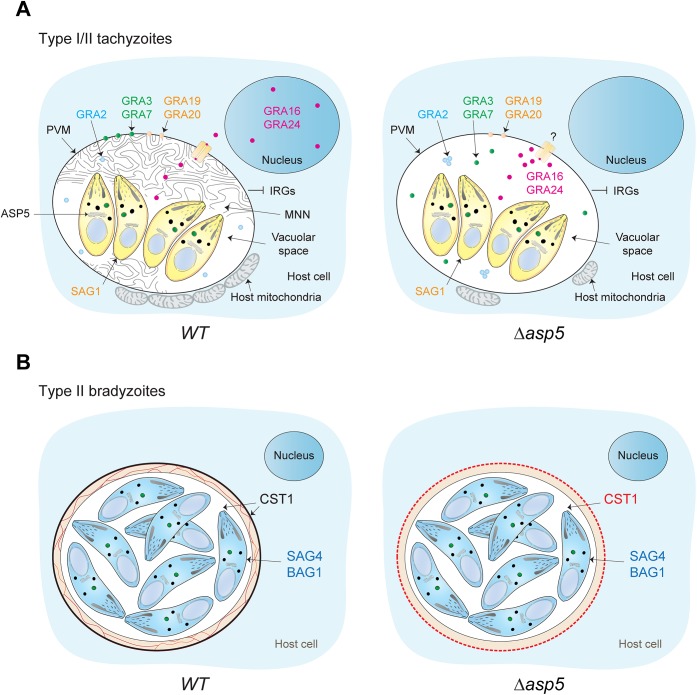
Stage specific functions of ASP5 in T. gondii.(A) Schematic representation of a host cell infected by either type I or type II tachyzoites. In a wt situation (left panel), intracellular tachyzoites reside within an MNN containing PV. During intracellular development, dense granule proteins are delivered either to the vacuolar space, the PVM, or are addressed to the host cell cytosol and nucleus. Intriguingly, the absence of ASP5 (right panel) does not affect the secretion of the dense granules, and accordingly, PEXEL-like and non-PEXEL-like motif-containing proteins are still delivered to the PV. However, ASP5 deletion leads to the disappearance of the MNN, altered localization of some PV- and PVM-resident GRAs, and to the PV-accumulation of proteins normally exported to the host cell cytosol. Accordingly, the overall infected host cell transcription profile response is significantly different in Δasp5 parasites infection. The accumulation of some exported GRAs in the PV suggests that the export machinery used to cross the PVM is affected upon ASP5 deletion. In contrast, no significant effect was observed for early host organelle recruitment to the PVM, but only a reduced fusion of host mitochondria was observed. Specifically in type I parasites, blocking of IRG recruitment is unaffected. SAG1 is a tachyzoite marker. (B) Differentiation in bradyzoites is not affected by ASP5 deletion but parasites fail to form a cyst wall. SAG4 and BAG1 are bradyzoite markers.